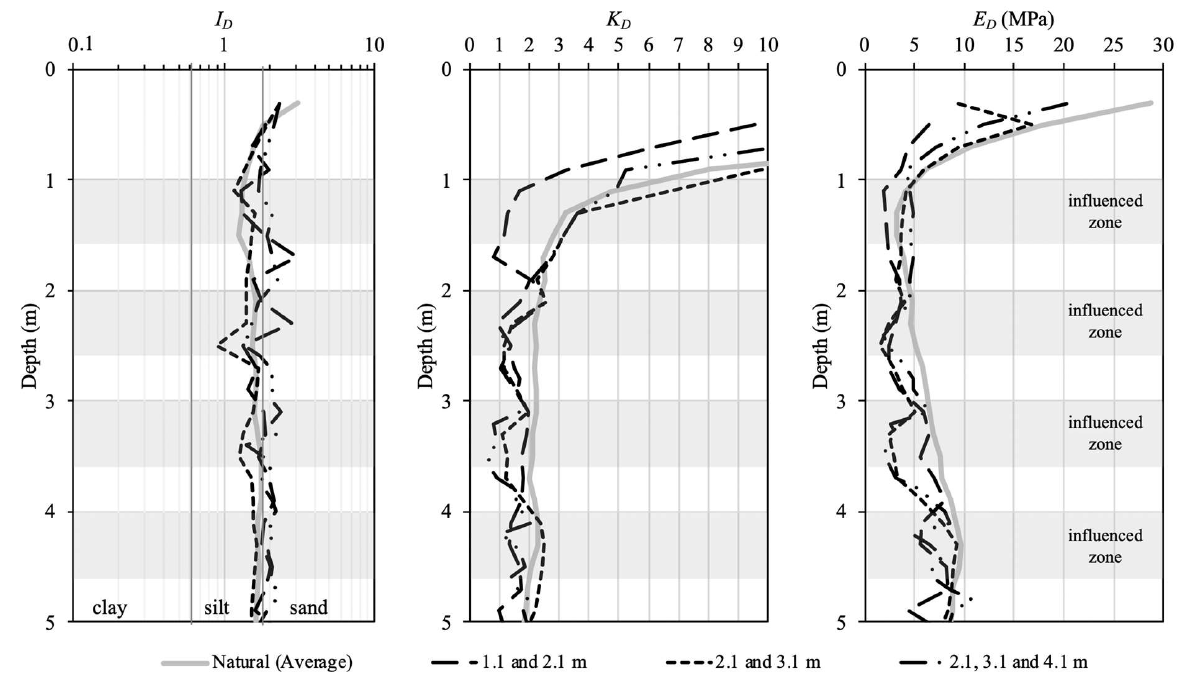
Figure 9. I D , K D , and E D profiles obtained after local inundation and average profile for the natural condition. Table 2. Intermediate parameters obtained for both natural and inundated conditions along the influenced zone (0.60